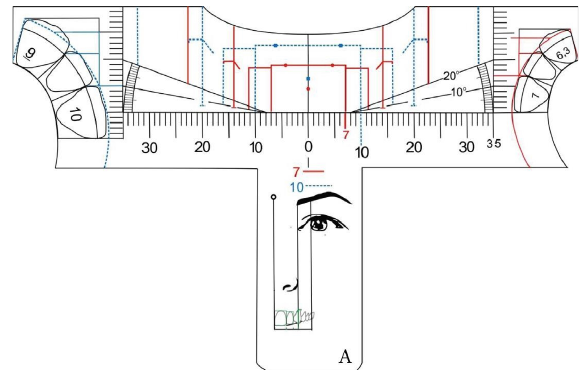
Figure 3: Front view illustration of one template showing metric scales and angles, diagrams and schematic drawings.